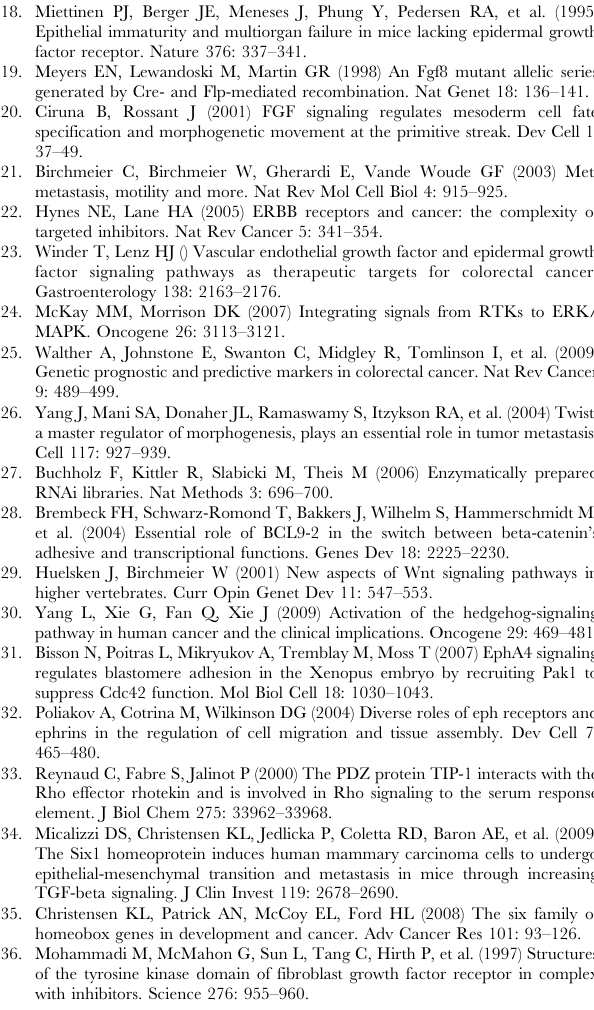
regulated genes. Green: downregulated genes after SU5402 treatment, red: upregulated genes after SU5402 treatment. Grey: non-regulated genes within the network. Network was derived from genes deregulated ( . 1.3-fold, p , 0.05) in expression profiles from biological triplicates of SU5402-treated SW480 cells and solvent controls. Profiles were normalized in Illumina Genome Studio using cubic spline normalization and background subtraction. Absent and marginally expressed genes were removed before analysis. Figure S7 An SW480-derived gene expression program associated with epithelial and mesenchymal morpholo- gy is also modulated in HCT116 cells. Analysis of gene expression in HCT116, 24 h after treatment with SU5402 or in solvent control (DMSO). Figure shows genes whose expression has previously been identified to correlate with mesenchymal or epithelial phenotypes in SW480 cells (see Fig. 5A). Genes that are not expressed in HCT116 were removed. Gene expression profiles were assessed using Illumina Sentrix Hu8-v2 bead chips according to manufacturer’s instructions. Data was processed from biological duplicates using Illumina Genome Studio, as detailed in the Material and Methods section. Red indicates high expression; blue low expression and white average expression.